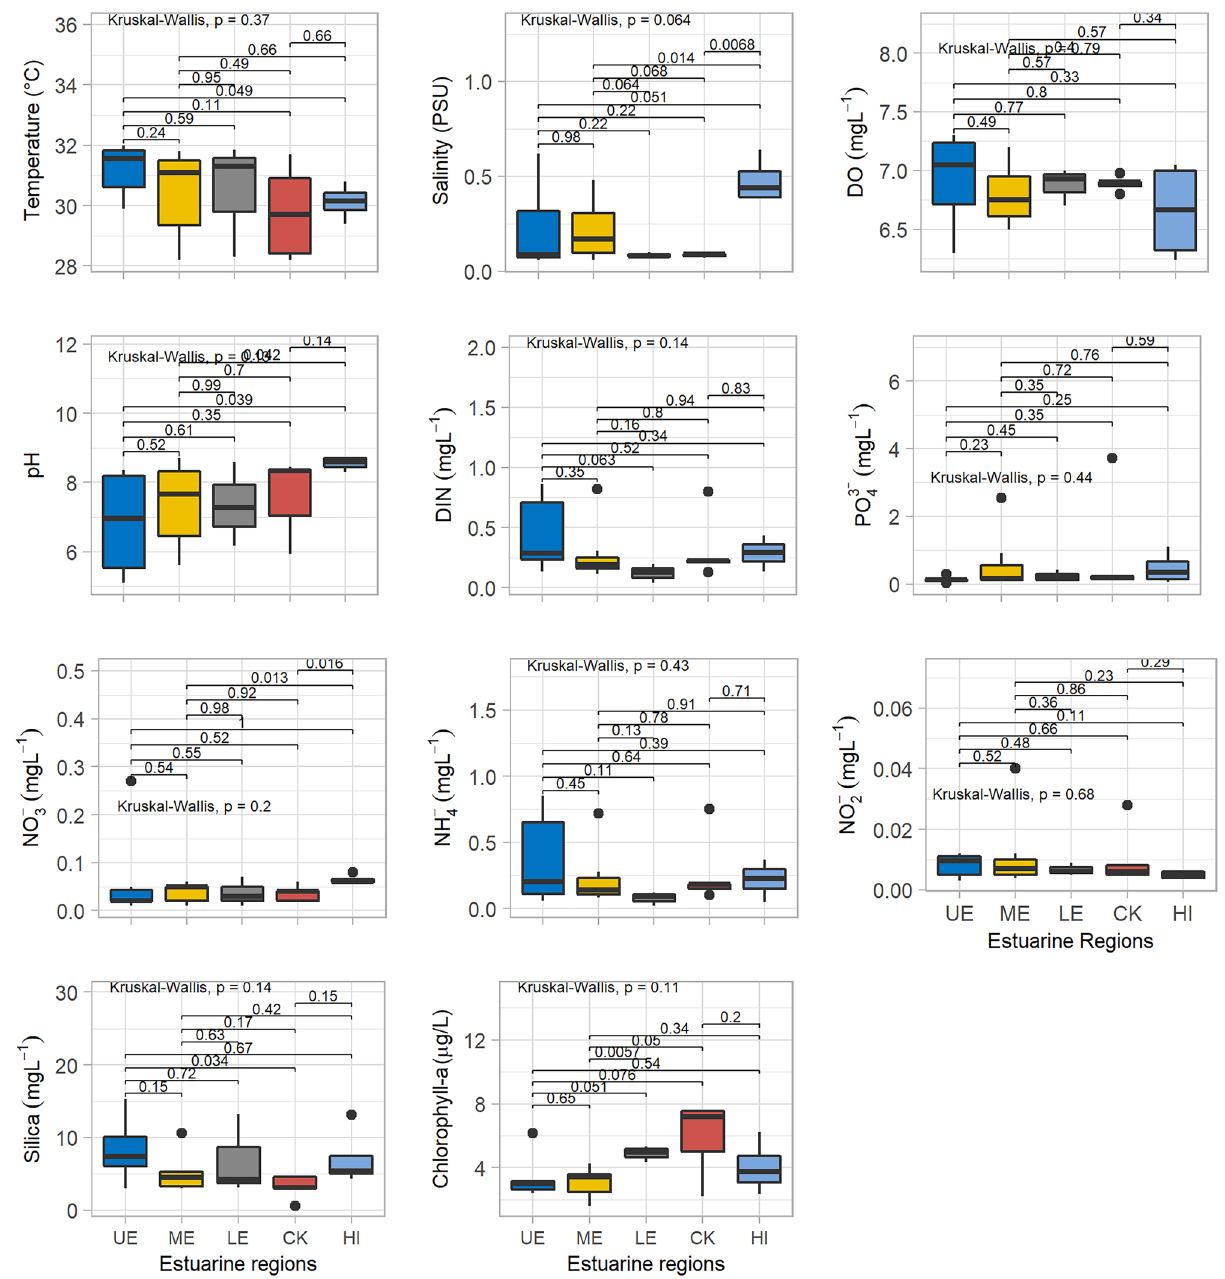
Figure 6. Spatial distributions of major hydro-chemical parameter, dissolved inorganic nutrients and chlorophyll-a in the lower Meghna River estuary during the wet season (UE = Upper estuary, ME = Middle estuary, LE = lower estuary, CK = Char Kukrimukri, HI = Hatiya Island). Note: the same for the Fig.